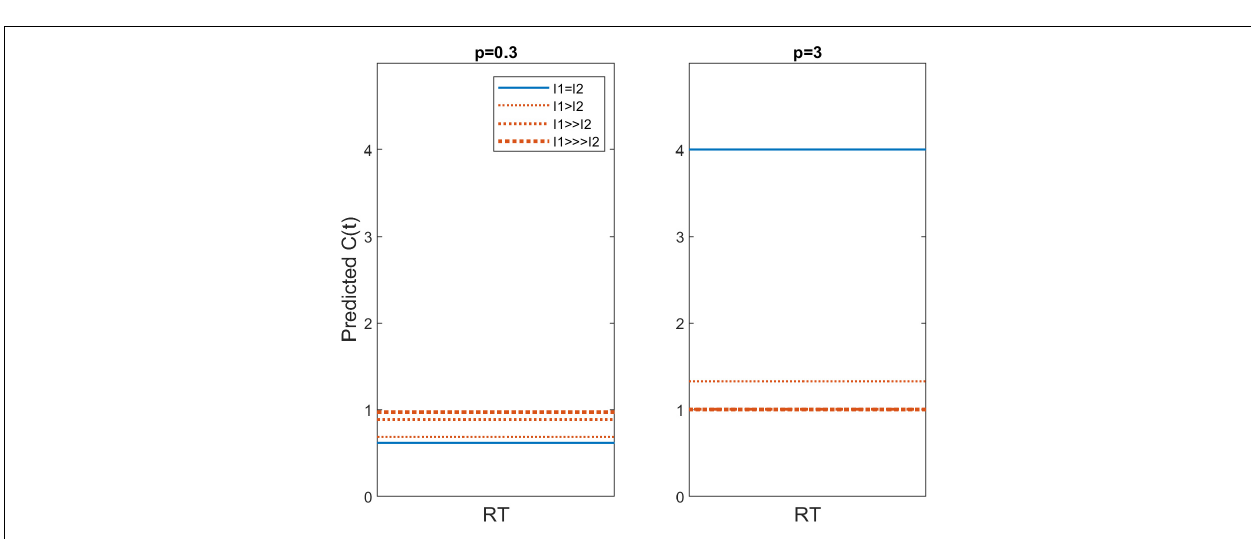
FIGURE 5 | Predicted survivor functions illustrating that the effects of the difference in stimulus intensity between the two targets leads to survivor functions for HH, HL, and LH being very similar to each other.